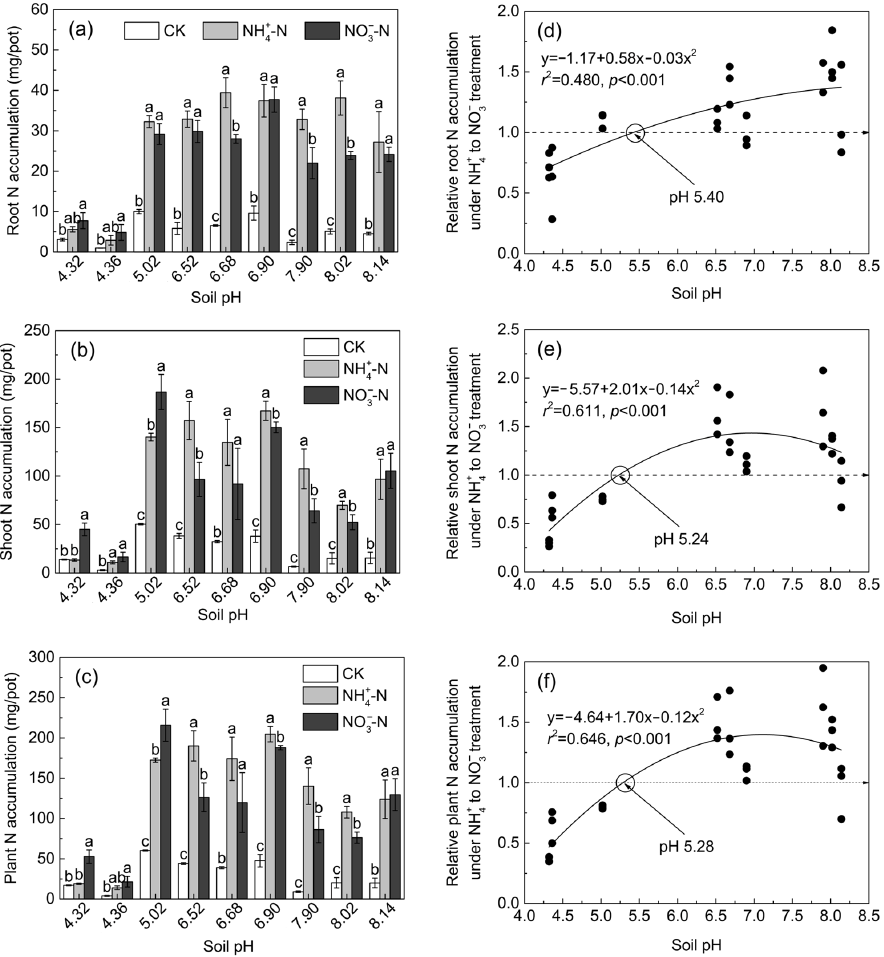
Figure 3. Effect of soil pH on the nitrogen (N) accumulation response of maize to ammonium (NH 4+ ) and nitrate (NO 3 − ) fertilizers. N accumulations in the root ( a ), shoot ( b ), and total plant ( c ). ( d – f ) Relative N accumulations in the root ( d ), shoot ( e ), and total plant ( f ). Maize seedlings were harvested after 30 days of growth. Relative N accumulation in maize was calculated as the ratio of N accumulation under NH 4+ treatment to that under NO 3− treatment. Different letters above bars indicate significant differences among NH 4+ , NO 3− , and control (CK) treatments in the same soil. According to the nonlinear regression analysis, N accumulation in maize roots, shoots, and whole plants (Figure 3d–f) and maize NRE (Figure 4b) under NH 4+ treatment relative to NO 3− followed the same trends as did maize dry weight (Figure 2d–f). When the value of the relative N accumulation of maize roots, shoots, or whole plants was 1.0 in the regression equation, the corresponding soil pH was 5.40, 5.24, or 5.28, thus indicating that maize N uptake under NH 4 + treatment was equivalent to that under NO 3 − treatment in soils with a pH of 5.24–5.40 (Figure 3d–f). Moreover, a relative NRE value of 1.0 corre- sponded to a soil pH of 5.23, which indicates that maize NRE under NH 4+ treatment was equivalent to that under NO 3− treatment in soils with a pH of 5.23 (Figure 4b). Further- more, NO 3− fertilizer would enhance maize N uptake and NRE compared with response to NH 4+ in soils with pHs below 5.23–5.40; in contrast, NH 4+ fertilizer would have this effect in soils with pHs above 5.23–5.40.